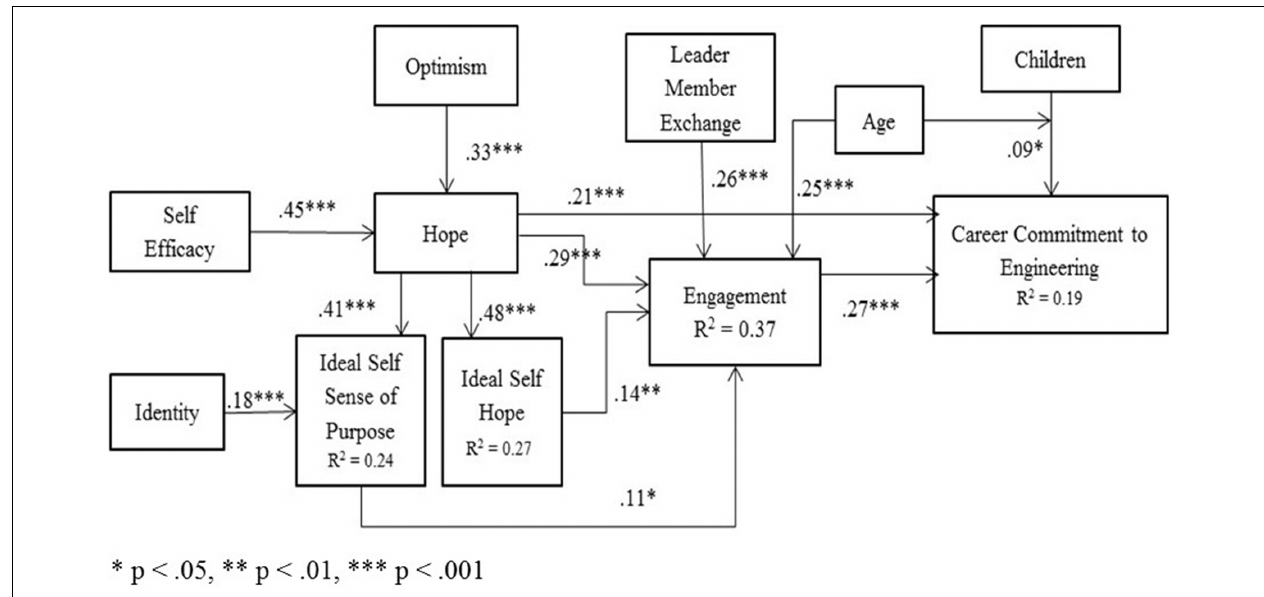
FIGURE 2 | Standardized solution for women’s career commitment to engineering.